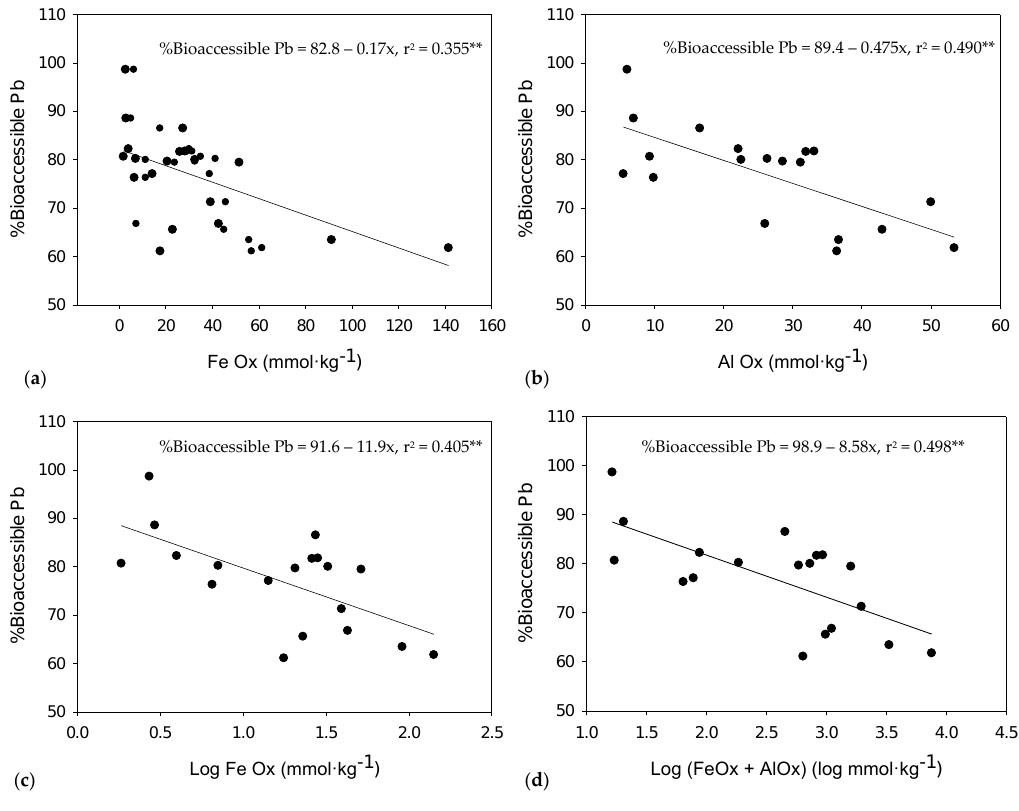
Figure 3. Effect of hydrous oxides on %bio-accessible (IVBA) Pb. ( a ) FeOx (mmol · kg − 1 ) effect on %bio-accessible Pb ( b ) AlOx (mmol · kg − 1 ) effect on %bio-accessible Pb ( c ) Log FeOx (mmol · kg − 1 ) effect on %bio-accessible Pb ( d ) Log (FeOx + AlOx) (log mmol · kg − 1 ) effect on %bio-accessible Pb.